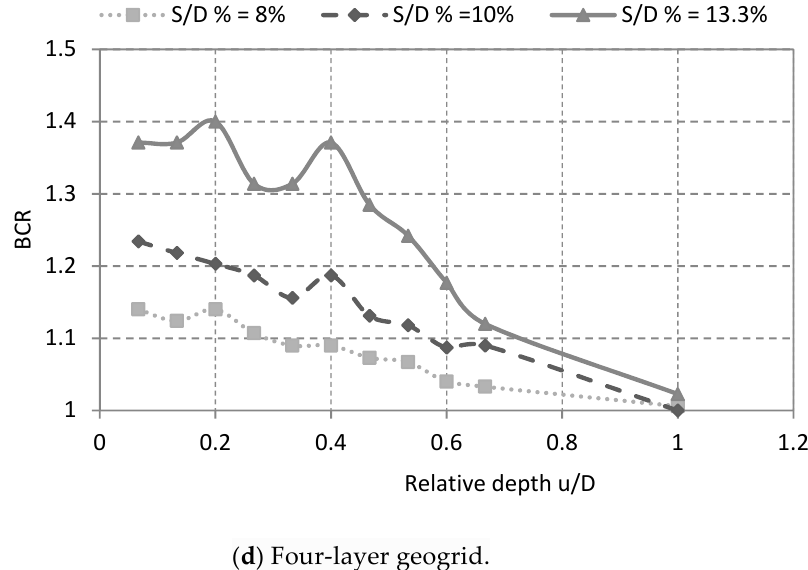
Figure 5. BCR as geogrid reinforcement layer moved deeper.